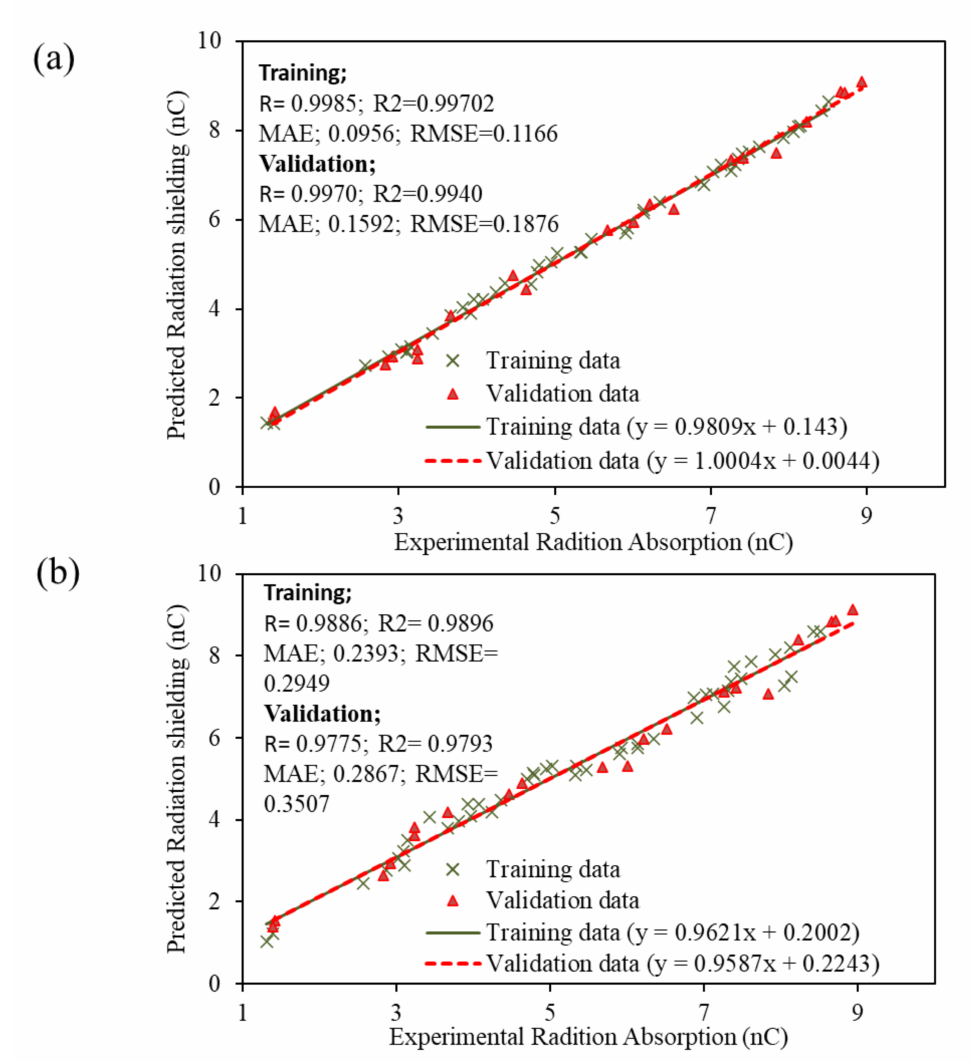
Figure 7. Comparison of experimental versus predicted results in the form of regression slopes and statistical indices: ( a ) ANN model, ( b ) GEP